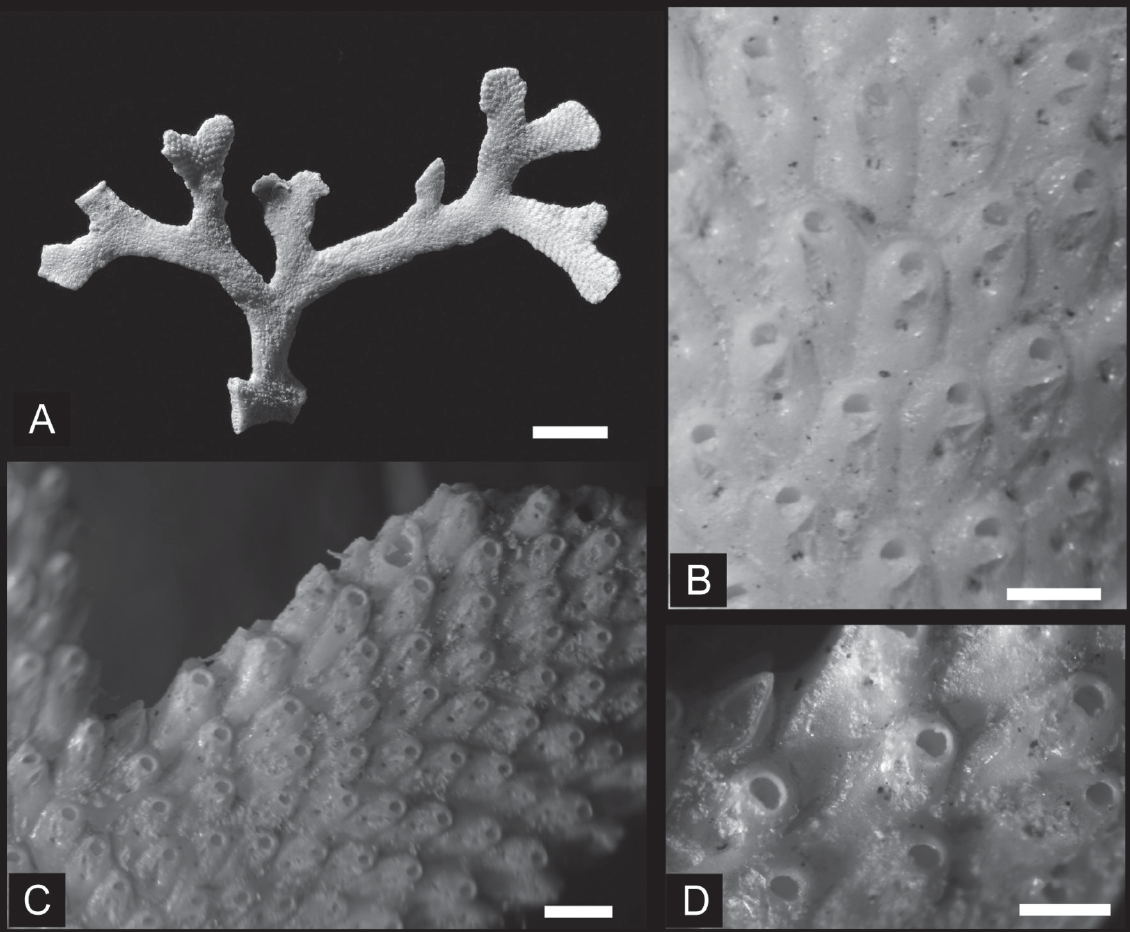
Fig. 9. Adeonellopsis japonica (ortmann, 1890) . A . Colony collected at Albatross station D, off oahu island, Hawaii (UsNM 271601). B . Autozooids of Hawaii specimen, showing suboral avicularia and biporous spiramen (UsNM 271601, Hawaii). C . Autozooids and lateral vicarious avicularia at a branch bifurcation (USNM 271601 paper box, Hawaii). D . enlargement of lateral vicarious avicularia at branch bifurcation (USNM 271601 paper box, Hawaii). A = optical photograph; B–D = photomicrographs. Scale bars: A = 5 mm; B, D = 300 μm; C = 500